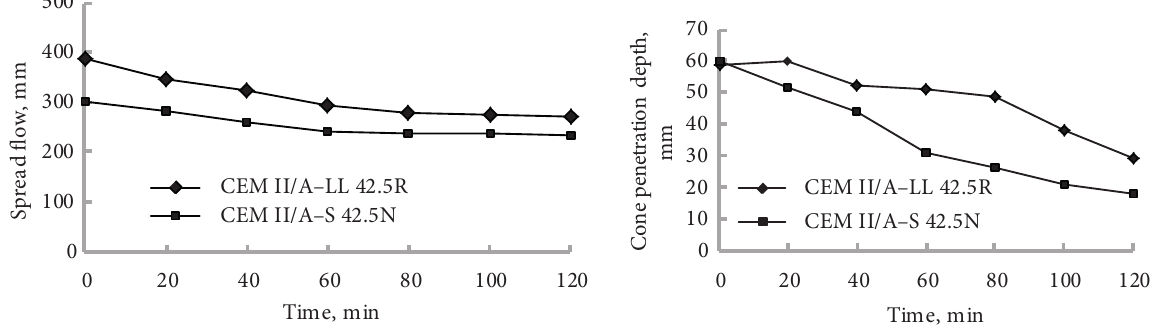
Fig. 6. A concrete mixture with different types of Portland cement and dependence of the superplasticizer having the spread flow of 1.25% on time at a temperature of +20 °C